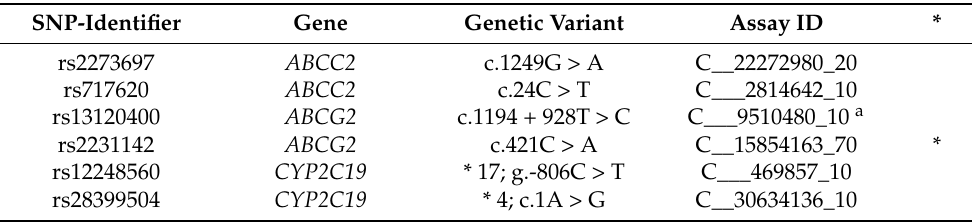
Table 1. Summary of genetic variants determined applying commercially available TaqMan ® assays (primer/probe-mixes) in this